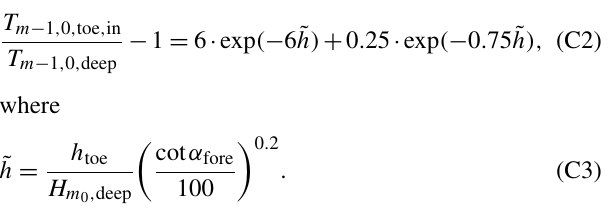
T m − 1 , 0 , toe T m − 1 , 0 , deep